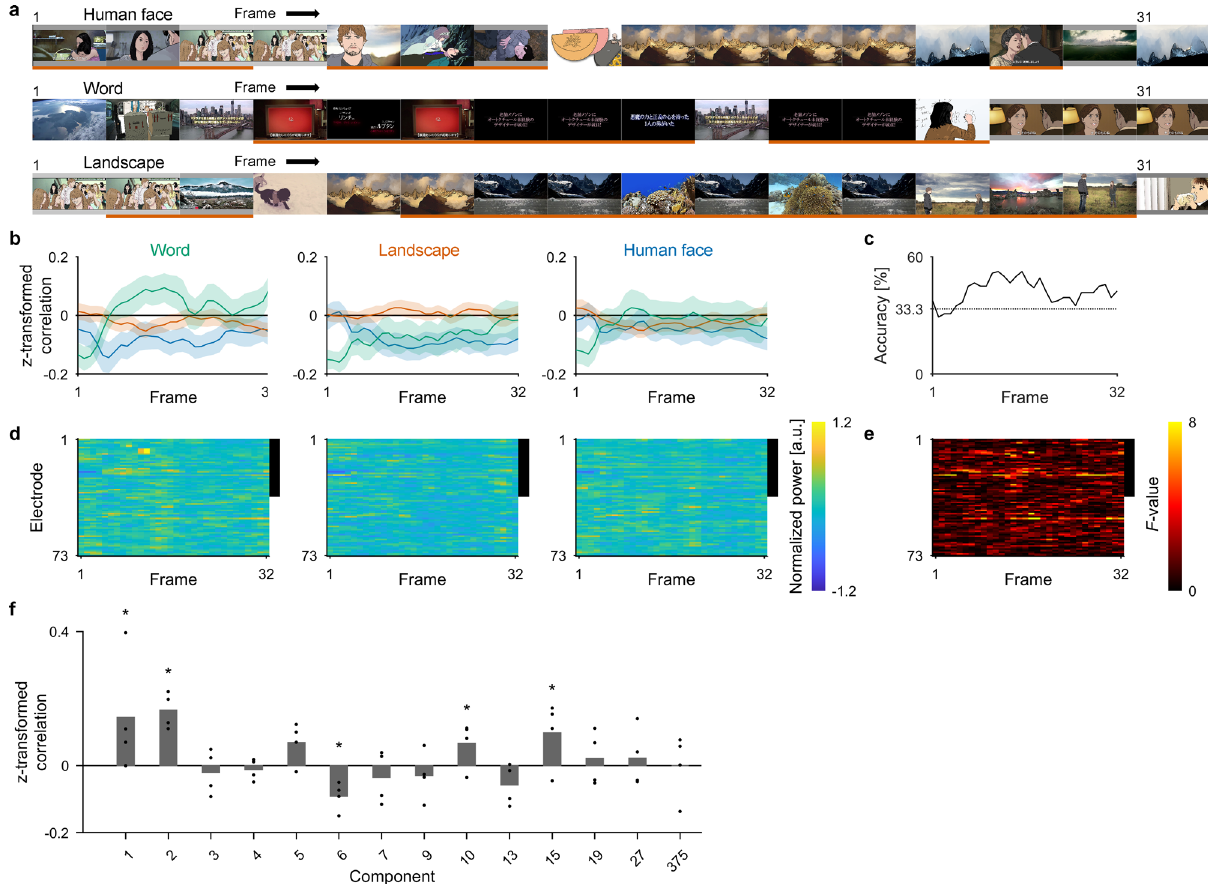
Fig. 5 Closed-loop performance in controlling the inferred images. a Representative feedback images are shown for E01 during trials 28 – 30 of the fi rst session with the corresponding target categories shown on the top. Due to the fi gure size, one of every two images is shown. The images underlined in red are the correct decoding in the context of a three-choice task in each frame; because the evaluation of the three-choice task is based on the inferred vector ( v online ), some frames have the same feedback images, but are differently classi fi ed. b For E01, the trial-averaged z ( R ( v online , v category )), where ( v category : v word , v landscape , or v face ), are shown as green, red and blue lines, respectively, with 95% CIs by the shaded area. The title of each panel indicates the target categories for the averaged trials. c The three-choice accuracy at each frame is shown. Dotted line denotes chance level (33.3%). d Power in the high- γ band during the feedback trials for each target category were averaged to be color-coded for each electrode and frame. The black line on the right side of the plot indicates the electrodes in the higher visual area. For visualization, the powers were z -scored across all trials and frames for each electrode. e For each electrode and frame, F -values of one-way ANOVA across the high- γ powers during the three target categories in ( d ) were color-coded. The black line on the right side of the plot indicates the : ¼ f v i ; j : ¼ f v i ; j electrodes in the higher visual area. f PrjR k ( V online , V target ) ( V g and V g where i ¼ 1 ; (cid:2)(cid:2)(cid:2) ; 120 ð trial Þ ; j ¼ 1 ; (cid:2)(cid:2)(cid:2) ; 32 ð frame Þ ) were Fisher online target target online z-transformed and averaged across all four subjects to be shown in order of the principal components. Here, PrjR k ( V online , V target ) was evaluated only for the 14 ; V ; V principal components whose z ð PrjR k ð V ÞÞ was positively signi fi cant in the video-watching task. The z ð PrjR k ð V ÞÞ was compared with the inferred true online target corresponding chance distribution for each component ( k ) ( z ð PrjR k ð V online ; f v i ; j gÞÞ where i isshuffled ð 1 ; (cid:2)(cid:2)(cid:2) ; 120 Þ ; j ¼ 1 ; (cid:2)(cid:2)(cid:2) ; 32). Individual values are shown target with dots. * P < 3.6×10 − 3 (Bonferroni-adjusted α -level; 0.05/14), two-sided permutation